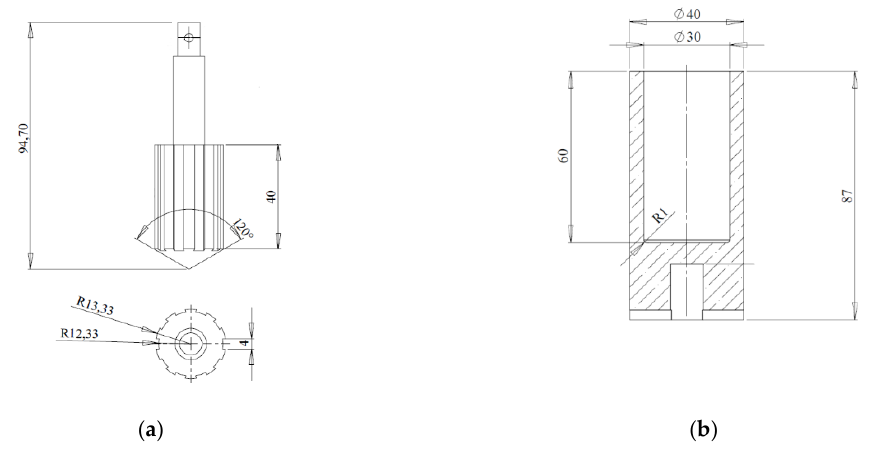
Figure 3. Measuring tools used for research, ( a ) bob; ( b ) cup.